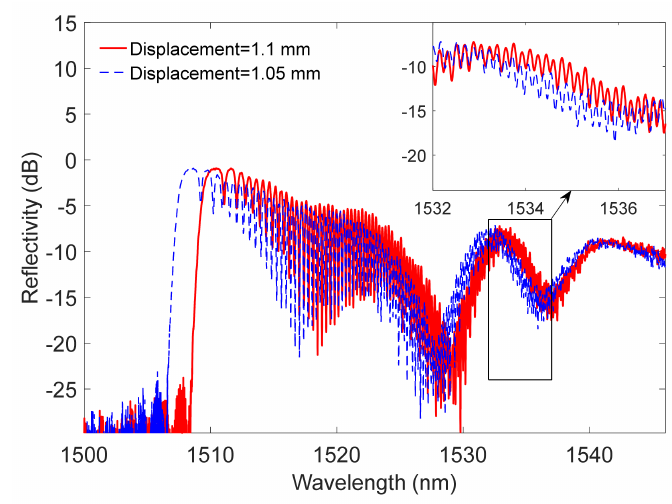
Figure 4. The F–P interferometer experimentally reflected spectra under displacements of 1.05 mm (blue dot line) and 1.1 mm (red